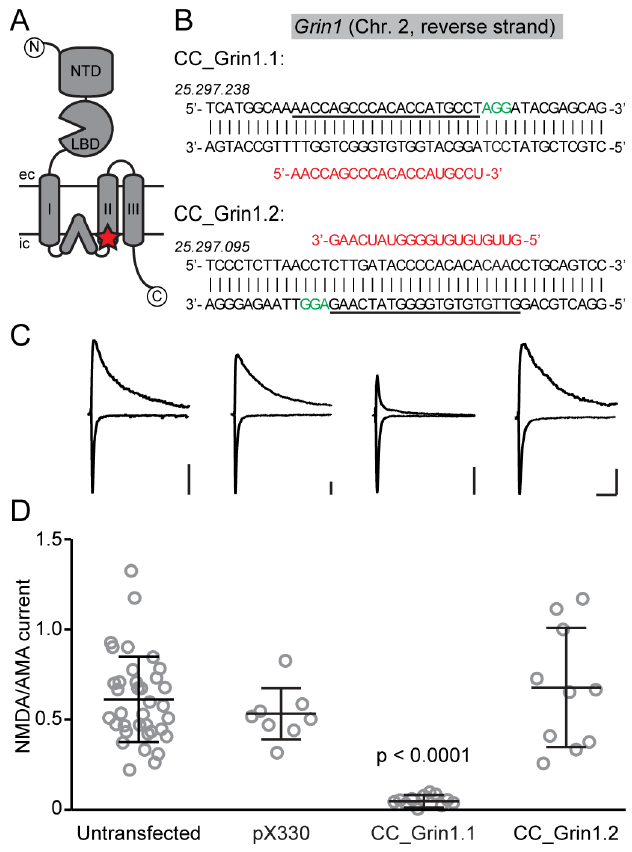
Figure 1. CRISPR/Cas9 mediated knock-down of NMDA receptors. (A) Schematic domain organization of a GluN1 subunit. Red star indicates location of the CC_Grin1.1 target sequence. Circled N/C indicate N-/C-terminus respectively; NTD: N-terminal binding domain; LBD: ligand binding domain; roman numbers indicate transmembrane domains 1–3, ec/ic: extracellular/intracellular. (B) Genomic sequences of CRISPR/Cas9 targets in GluN1. Grin1 (encoding for mouse GluN1) is located on the reverse strand of chromosome 2, and the third transmembrane domain is encoded by exon 14. Target sequences are underlined, crRNA sequences are in red, PAM sequences in green. Numbers above DNA strand indicate chromosomal position. (C) Example traces of AMPAR currents (recorded at 2 70 mV, inward) and NMDAR currents (recorded at + 40 mV, outward) from acute brain slices. From left to right: untransfected, pX330 (‘empty’ CRISPR/Cas9 without targeting sequence), CC_Grin1.1, CC_Grin1.2. Scale bars are 50 pA and 100 ms. (D) NMDAR/AMPAR current ratio for all cells. Untransfected control cells were interleaved with neighboring GFP-positive experimental cells. AMPAR current amplitude was measured as the peak inward current at 2 70 mV, while NMDAR current amplitude was measured 100 msec after stimulation at + 40 mV, to avoid contamination with AMPARs. Bars indicate mean 6 S.E.M., grey circles individual cells. Transfection with CC_Grin1.1 completely eliminated NMDAR currents (Kruskall-Wallis test, followed by Dunn’s test).